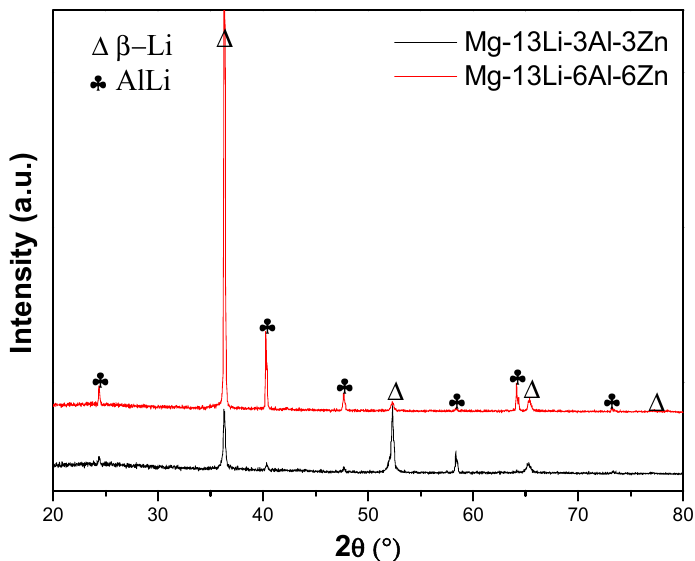
Figure 3. The XRD patterns of as-cast LAZ13 xy ( x = 3, 6 wt%, y = 3, 6 wt%) alloys. The as-cast LAZ1366 alloy was then subjected to TEM analysis. As shown in Figure 4a, the precipitation phase in the alloy is micrometer-scale, and the spinodal decomposition appears around the precipitation phase. The HRTEM characterization of the spinodal decomposition is shown in Figure 4b. Figure 4c is the FFT result of region 1, which shows a typical BCC[001] axis, which is β -Li matrix. Figure 4d shows the FFT result of the spinodal decomposition in region 2, which shows a typical BCC[122] axis. According to the HAADF-STEM and EDS results shown in Figure 5, these micrometer-scale precipitates hardly contain Mg elements, and only contain Al and Zn elements. It can be seen from the EDS results that the atomic ratio of Al and Zn elements in the precipitation phase is close to 3:1. Combining with the XRD results (Figure 3) and related literature [15–17], the micrometer-scale precipitation phase is AlLi phase. However, no Zn-containing compounds were found in LAZ1333 alloy and LAZ1366 alloy, which was mainly because the maximum solid solubility of Zn in Mg is about 6.2 wt.%, and the Zn element was completely dissolved in the matrix [18,19].